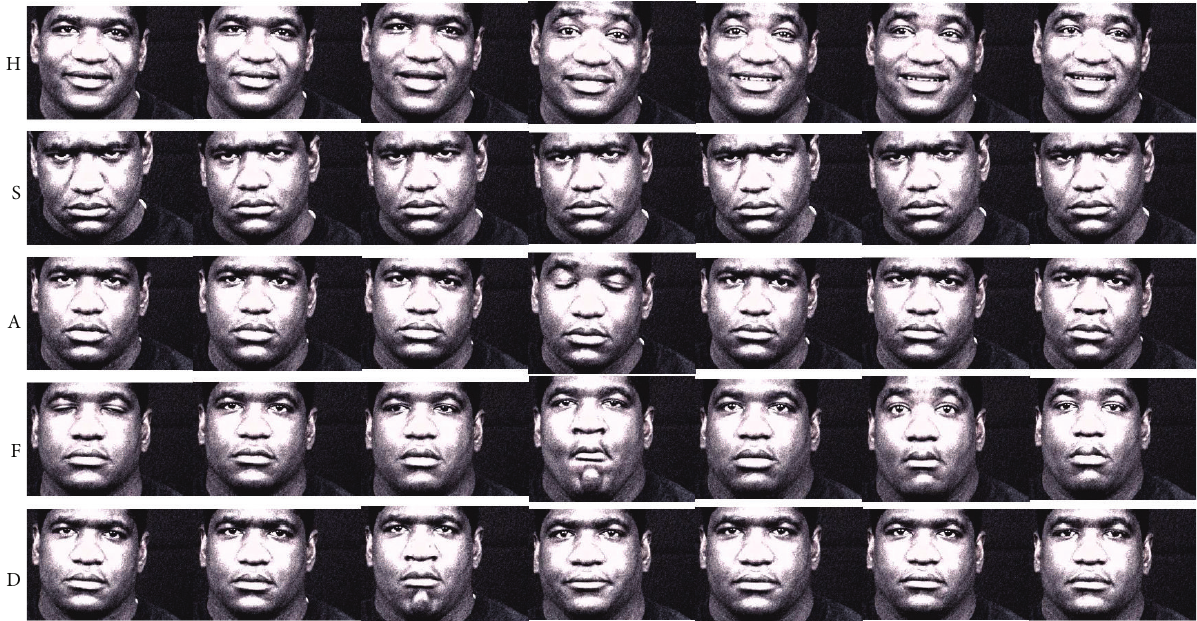
Figure 4: Sample videos of a subject with high ambiguity and high distinctiveness . High ambiguity and high distinctiveness also appear as inappropriate facial expressions due to the lack of consistent patterns within each emotion.